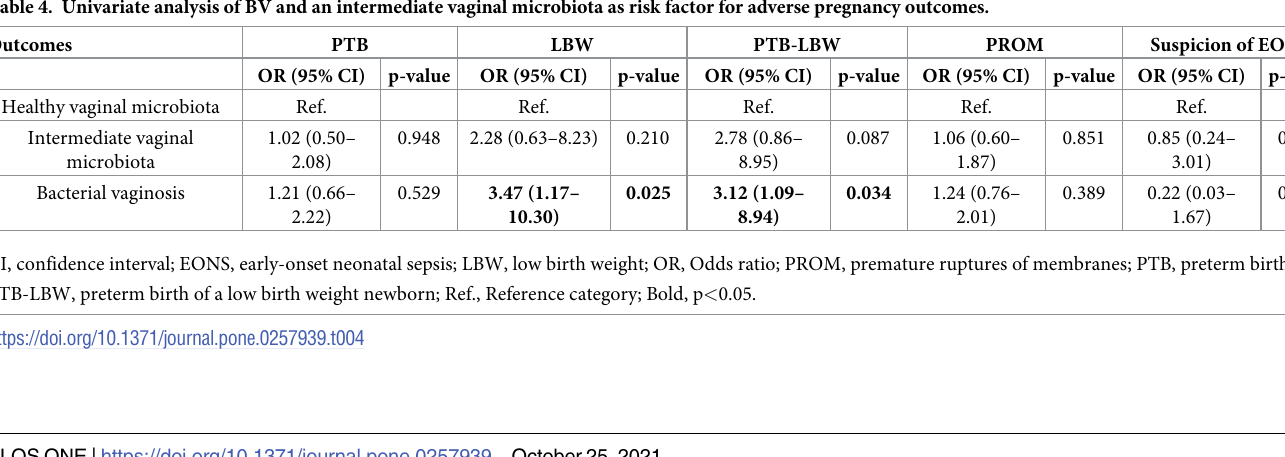
Table 4. Univariate analysis of BV and an intermediate vaginal microbiota as risk factor for adverse pregnancy outcomes. Outcomes PTB LBW PTB-LBW PROM Suspicion of EONS Healthy vaginal microbiota Ref. Ref. Ref. Ref. Ref. Intermediate vaginal microbiota Bacterial vaginosis